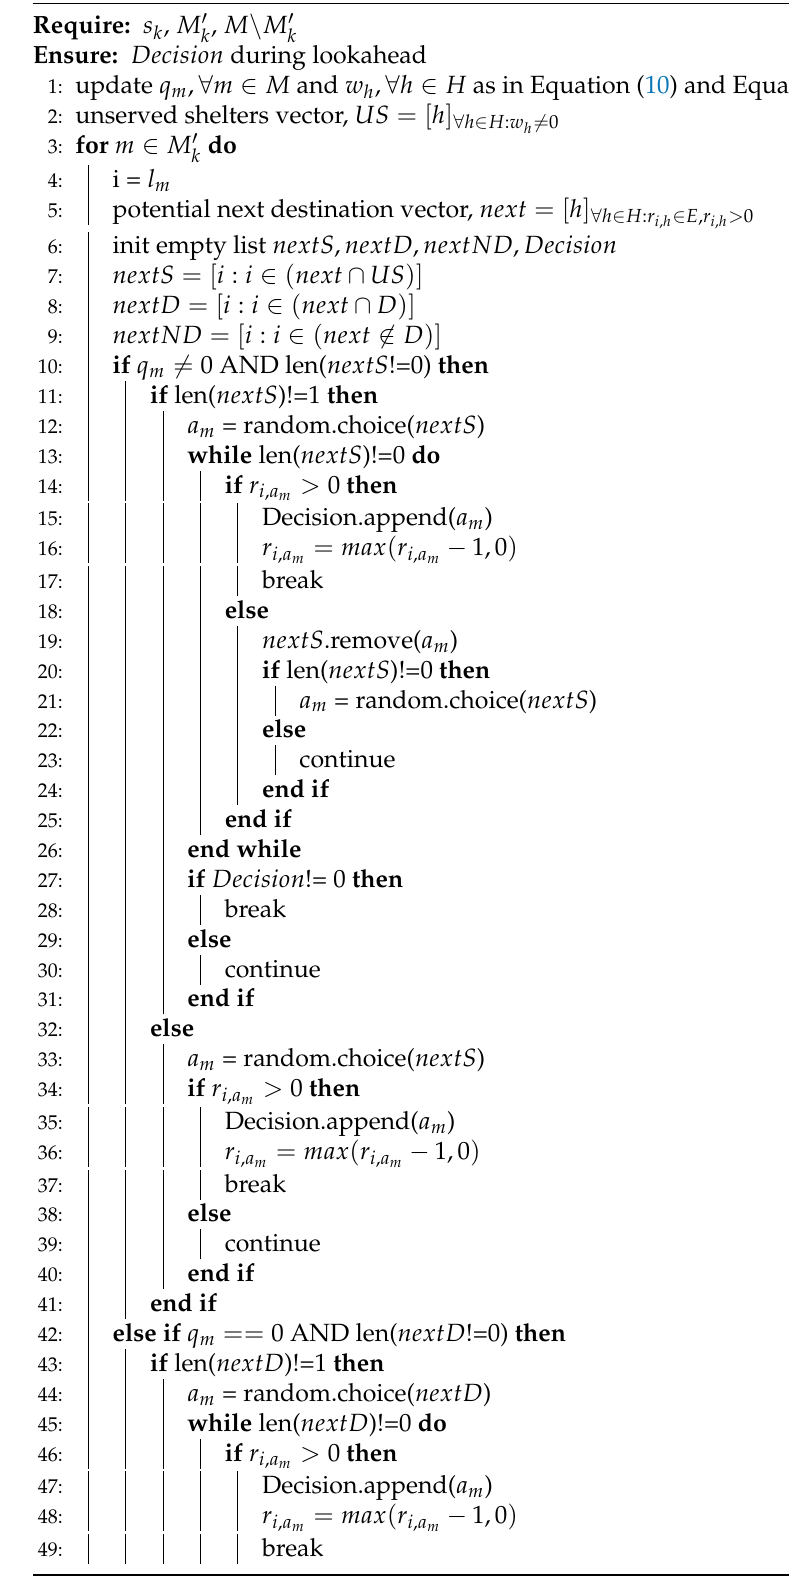
Algorithm 4 TBIH-1 and General Structure Algorithm. (Note: | M (cid:48)